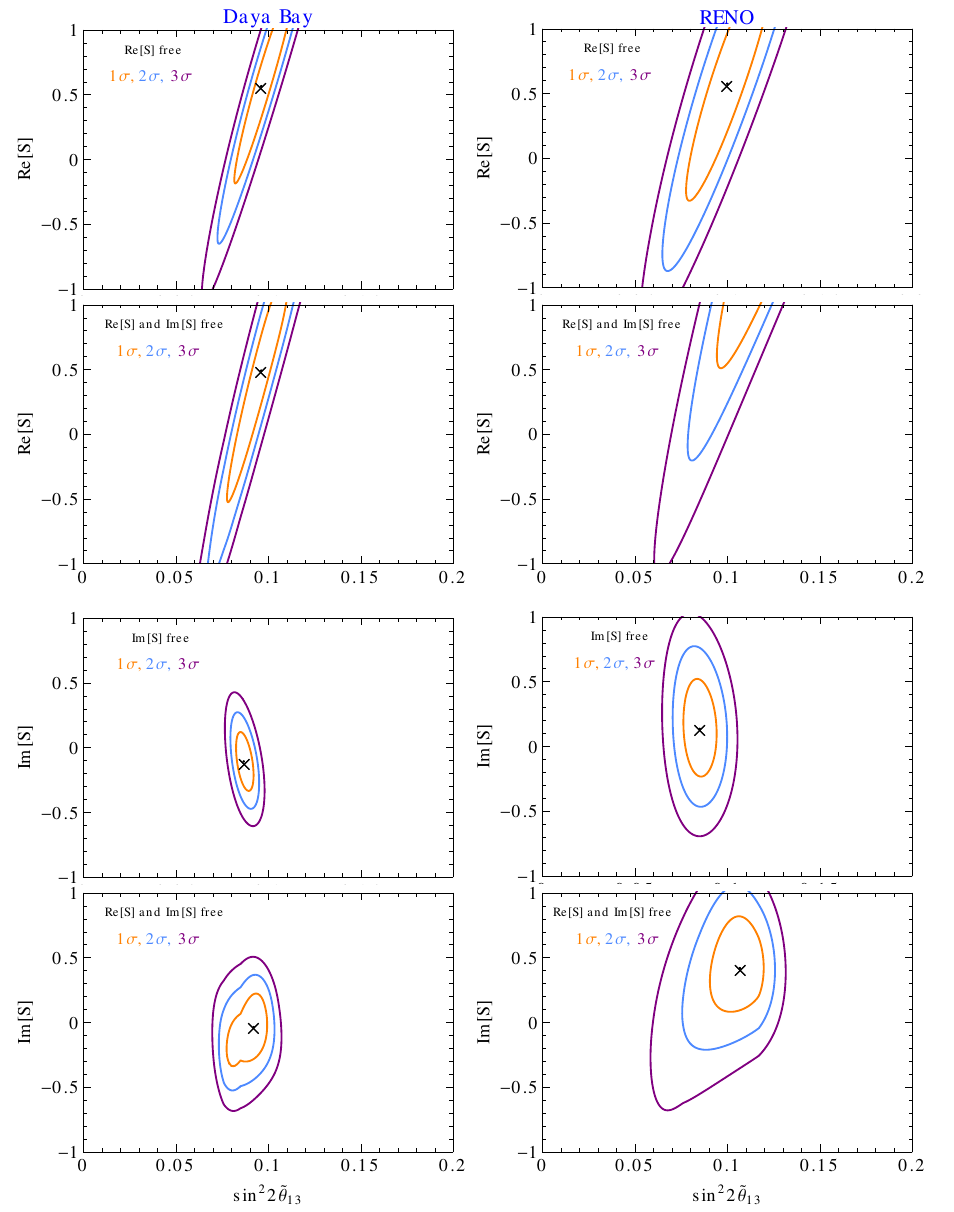
Figure 5 . Allowed regions in the (sin 2 2~ (cid:18) 13 (cid:0) Re [ S ]) ((cid:12)rst and second rows) and (sin 2 2~ (cid:18) 13 (cid:0) Im [ S ]) plane (third and fourth rows), for the Daya Bay (left) and RENO (right) experiments. The 1-, 2-, and 3- (cid:27) regions are shown with orange, blue, and purple, respectively. The best (cid:12)t values are marked by (cid:2) .